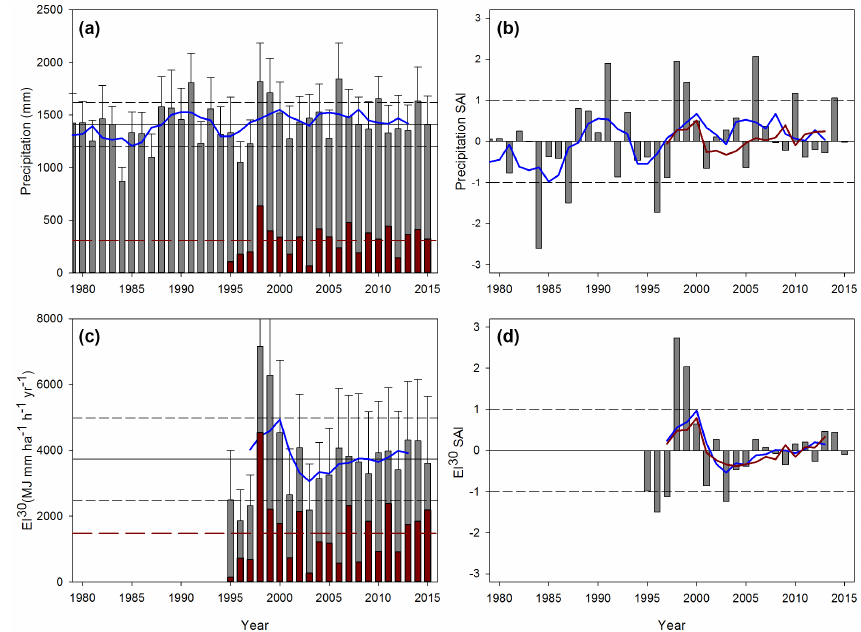
Figure 3. Annual (grey) and typhoon-related (red) mean annual precipitation (a) and corresponding standardized anomaly index (SAI – b ) and the annual (grey) and typhoon-related (red) R factor (c) and the R factor’s SAI (d) . The grey solid line represents the regional mean (including typhoons) and the grey dashed lines represent 1 standard deviation from the total mean, whereas the red dashed line represents the mean contribution from typhoon events. The blue (total) and red (typhoon) solid lines depict the 5-year running average.